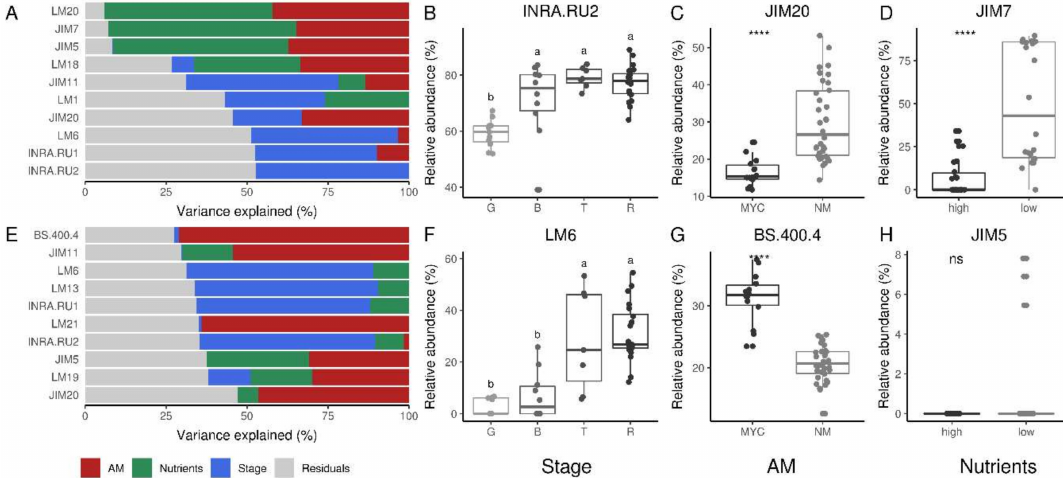
Figure 6. Variance partitioning analysis (VPA) of the tomato fruits glycome under mycorrhizal (MYC), fertilized (FERT), and non-mycorrhizal (NM) conditions. ( A , E ) Variance explained by each factor (ripening stage, AM colonization, and fertilization treatment) for the top 10 best correlated antibodies for the CDTA and NaOH fraction, respectively. The most well-correlated antibody for each factor is depicted in boxplots for CDTA ( B – D ) and NaOH ( F – H ) fractions. Fruits were analyzed at four different ripening stages: “mature green” (G), “breaker” (B), “turning” (T), and “red” (R). Significant differences according to Kruskall–Wallis tests were reported with asterisks (**** p ≤ 0.0001) or letters (data indicated with different letters are statistically different, ns = not-significant